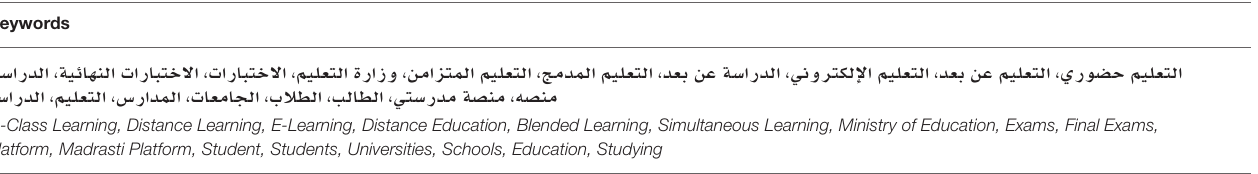
TABLE 1 | Data collection: keywords and hashtags.